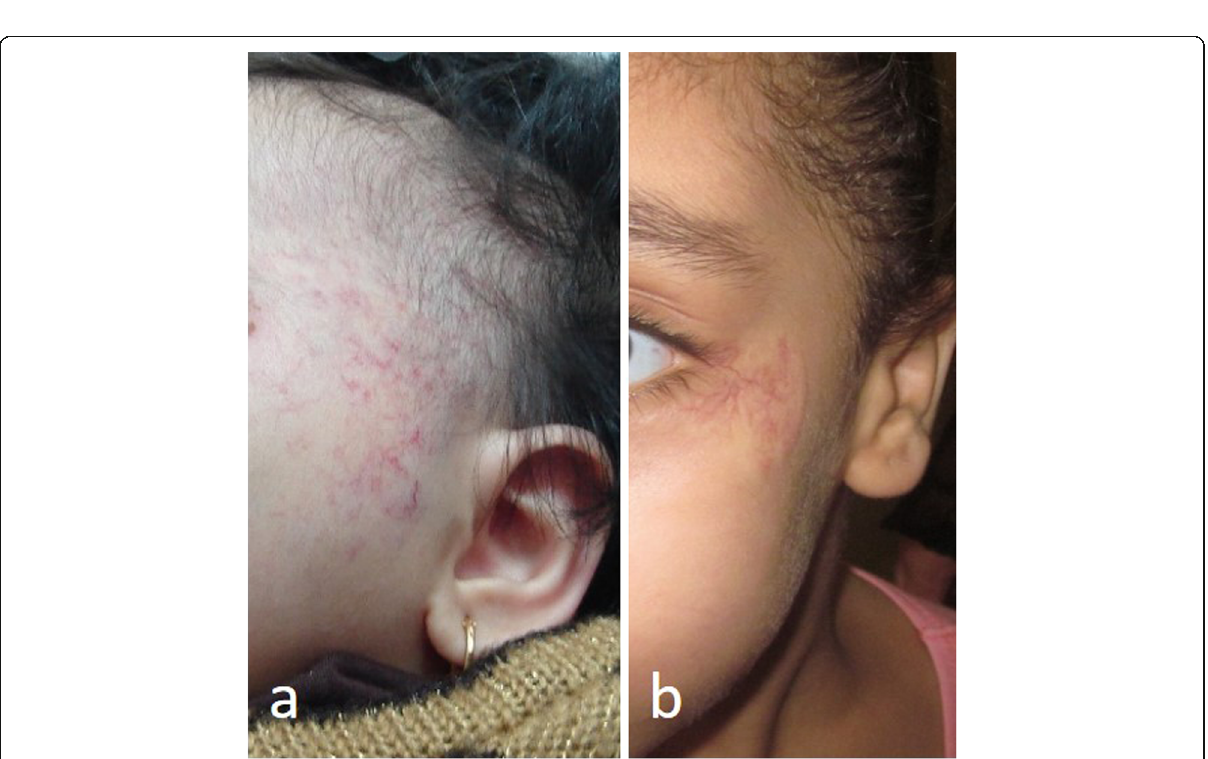
Fig. 5 Infantile haemangioma in the face of two different cases after stoppage of medical treatment and going into